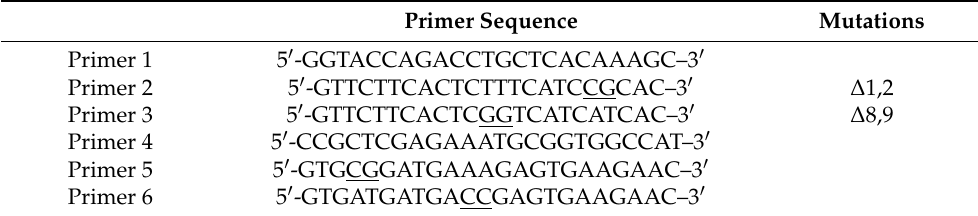
Table 1. Primers used in C/EBP site mutagenesis. The positions of mutations are underlined. Primer Sequence Mutations Primer 1 5 (cid:48) -GGTACCAGACCTGCTCACAAAGC–3 (cid:48) Primer 2 ∆